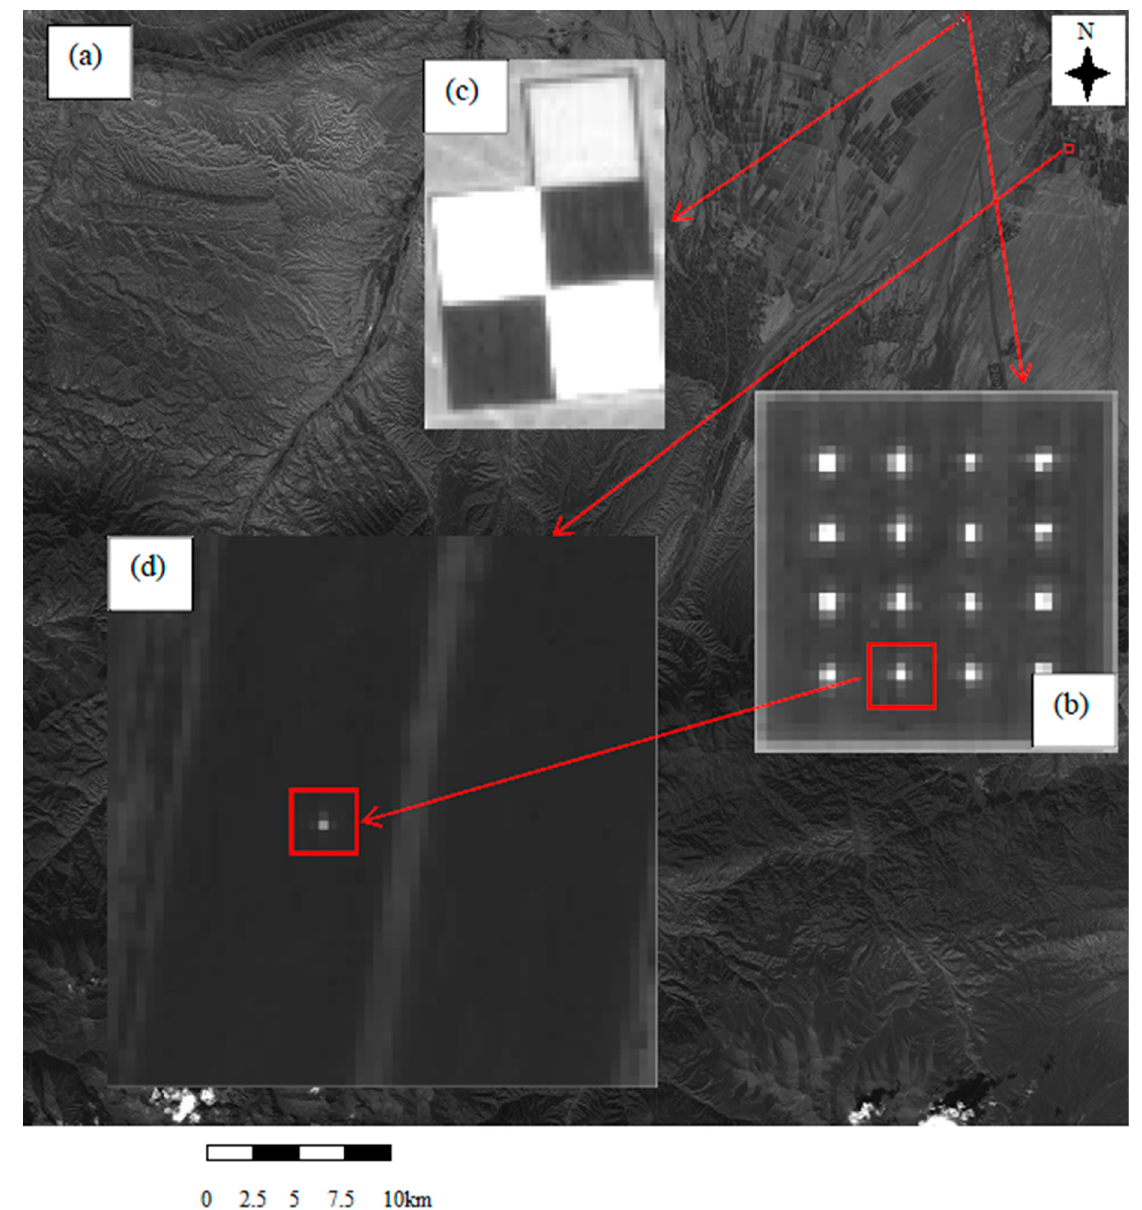
Figure 4. Experimental data: ( a ) Satellite imagery; ( b ) point source target image; ( c ) large area grayscale target image; and ( d ) image patch containing a point source target.